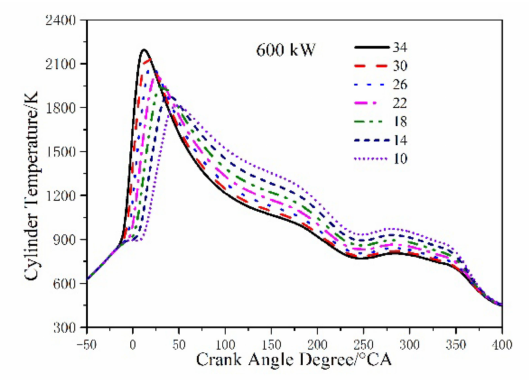
Figure 9. Cylinder temperatures.